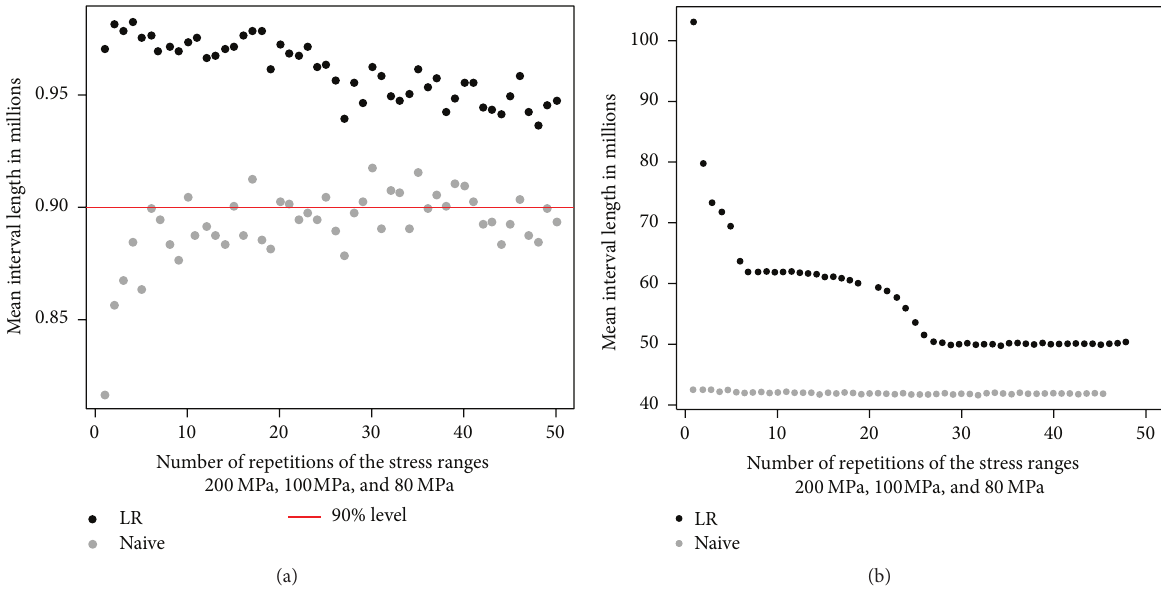
Figure 6: Coverage rates (a) and mean interval lengths (b) of the 90% prediction intervals using the likelihood ratio and the naive approach.